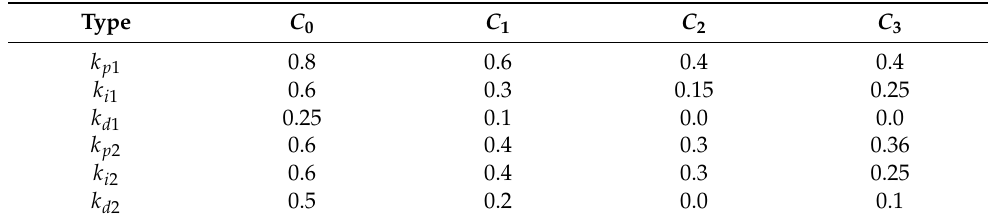
N for the system.